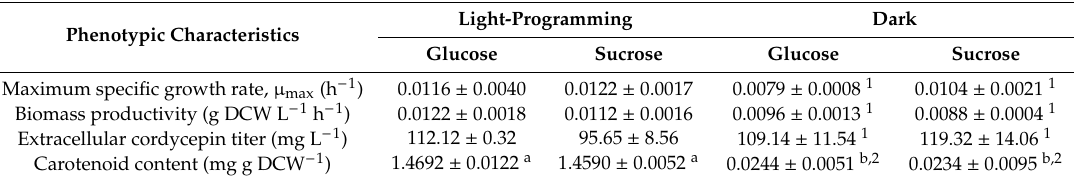
Table 1. Growth and production of carotenoid and cordycepin of the glucose and sucrose cultures of C. militaris at light-programming and dark